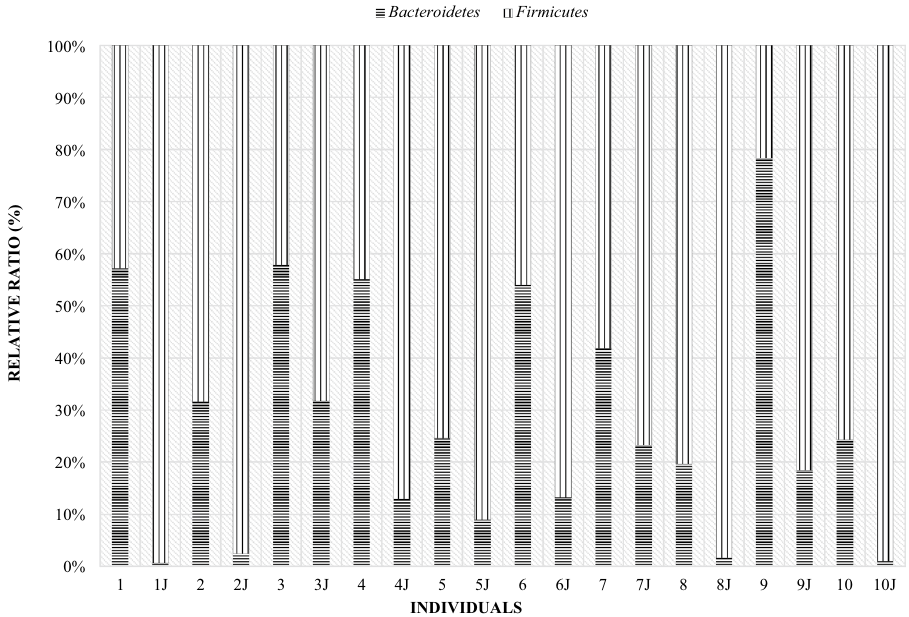
Figure 17. Compare of Firmicutes and Bacteroidetes phylum at day of birth in mother and their twins digestive tract (day 0) (1—mother, 1 J—twins).